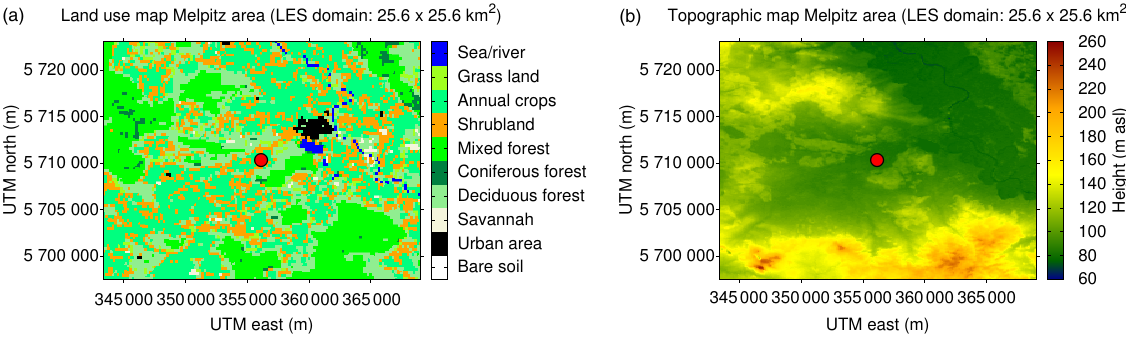
Figure 1. Land use and topography of the simulation domain considered in the All Scale Atmospheric Model (ASAM; Jähn et al., 2015) around the Melpitz field site, located in the domain centre (red dot). The large variation in vegetation on a small scale is indicated by different colours (a) and the topography ranging from 60 to 260m above sea level (a.s.l.) is also indicated with the same resolution (b) .